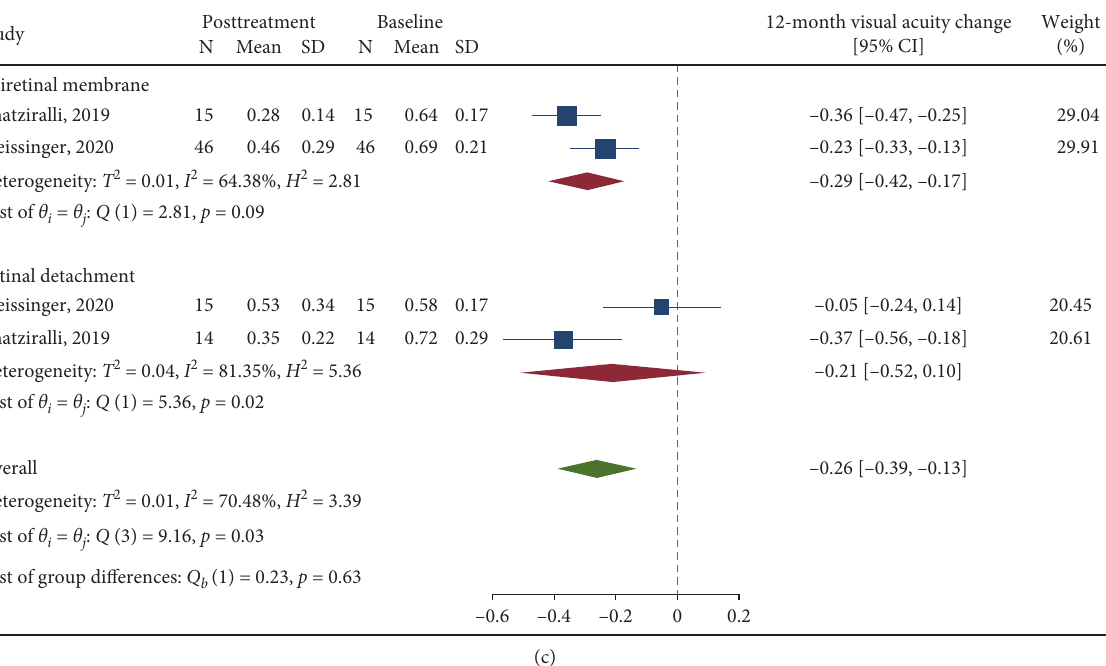
Figure 3: A forest plot showing mean change in best-corrected visual acuity at 1-month (a), 6-month (b), and 12-month (c) follow-up after treatment with dexamethasone